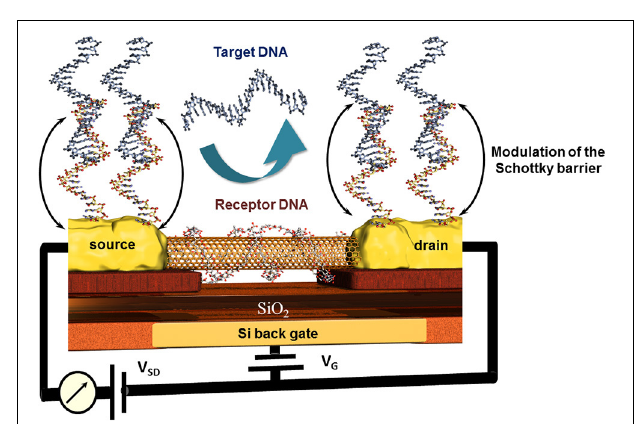
FIGURE 8 | Principle of the modulation of the Schottky barrier at source and drain electrodes of CNT field effect transistor devices after hybridization of the receptor DNA with the target DNA. Here, the wrapping properties of DNA around nanotubes inhibit the capability of this receptor DNA to hybridize with its counterpart and thus deactivate indirectly the CNT channel which remains unaffected toward the recognition